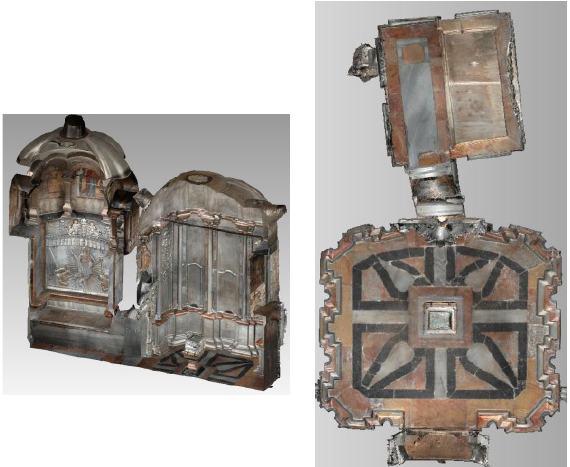
Figure 5. Vertical and horizontal sections of the 3D model showing its interior